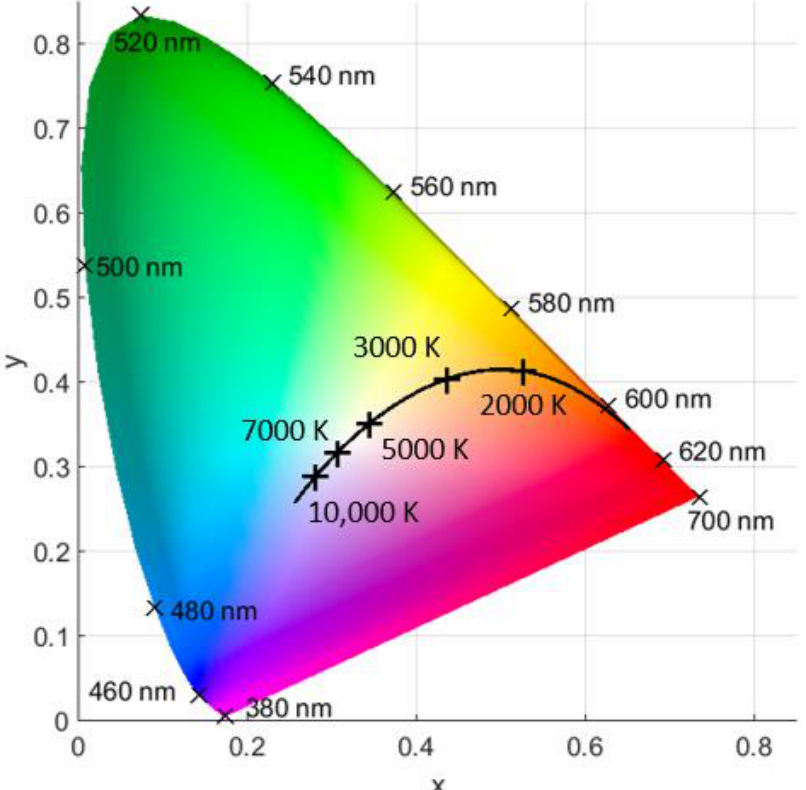
Figure 1. The CIE 1931 color space chromaticity diagram with inserted black body curve (black line) and markers for colors of different wavelengths.